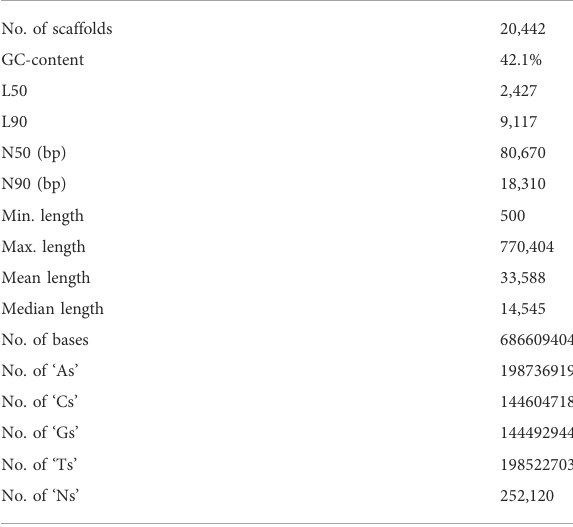
FIGURE 1 K-mer frequency coverage. The graph indicates the frequency of observed kmers using which the genome size is estimated. The jelly fi sh histo fi le was used as the input and the graph was constructed using the GenomeScope tool (http:// qb.cshl.edu/genomescope/).